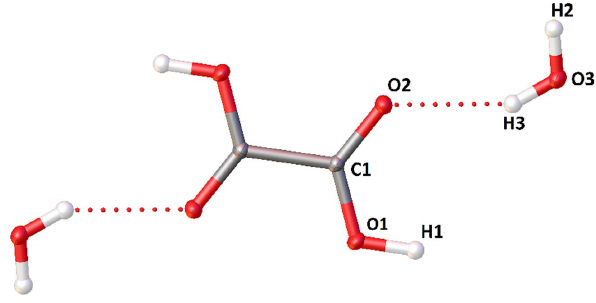
Figure 1 Labelling of atoms in oxalic acid dihydrate. The molecule of oxalic acid is located at a special position (inversion centre located at the midpoint of the C1—C1 bond) and is accompanied by two molecules of H 2 O. The asymmetric part of the unit cell consists of those atoms which are